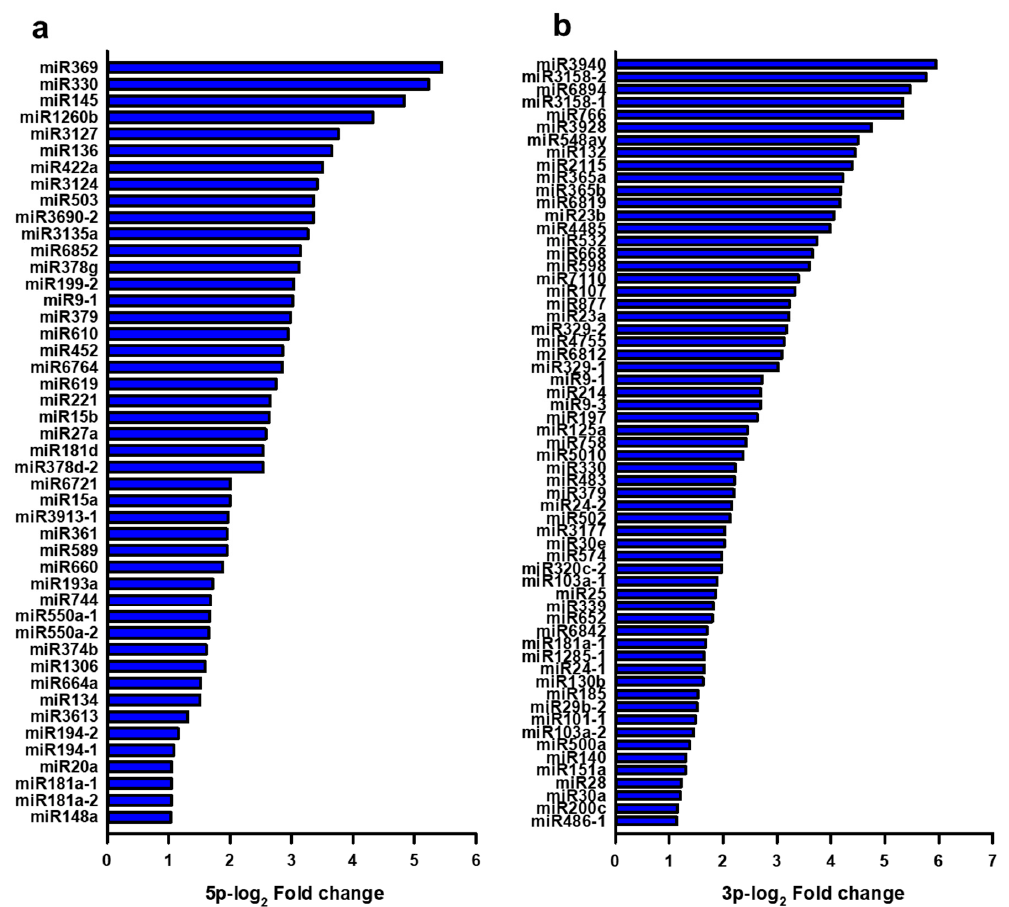
Figure 3. The expression profiles of miRNA extracted from serum exosomes were assessed using next-generation sequencing (NGS) analysis. The correlation analysis of microRNA (miRNA) expression in patients with focal cortical dysplasia and controls: 107 miRNAs showed statistically significant expression ( p < 0.05), as assessed by a Student’s t-test. The bar chart indicates the 5p- ( a ) and 3p- ( b ) log 2 ratio levels of mature miRNAs, sorted from highest to lowest in patients normalized to normal controls. log 2 (mean of miRNA in patients/mean of miRNA in controls) expressed as log 2 fold change.